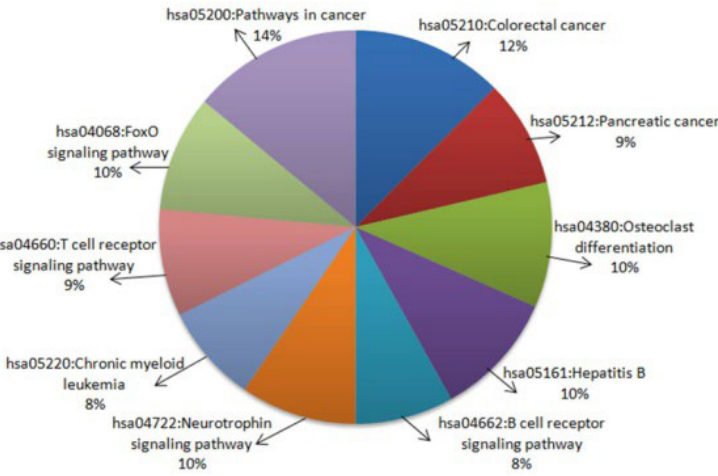
Figure 3. Pathways analyzed using the DAVID database.